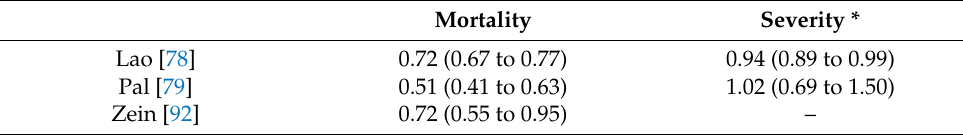
Table 4. Odds ratio (95% confidence interval) of the effects of statins on COVID-19